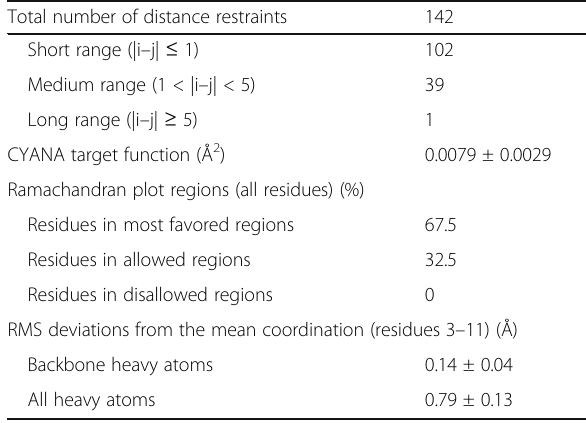
Table 2 The final constraints and structural statistics for KR-12- pa Total number of distance restraints 142 Short range (|i – j| ≤